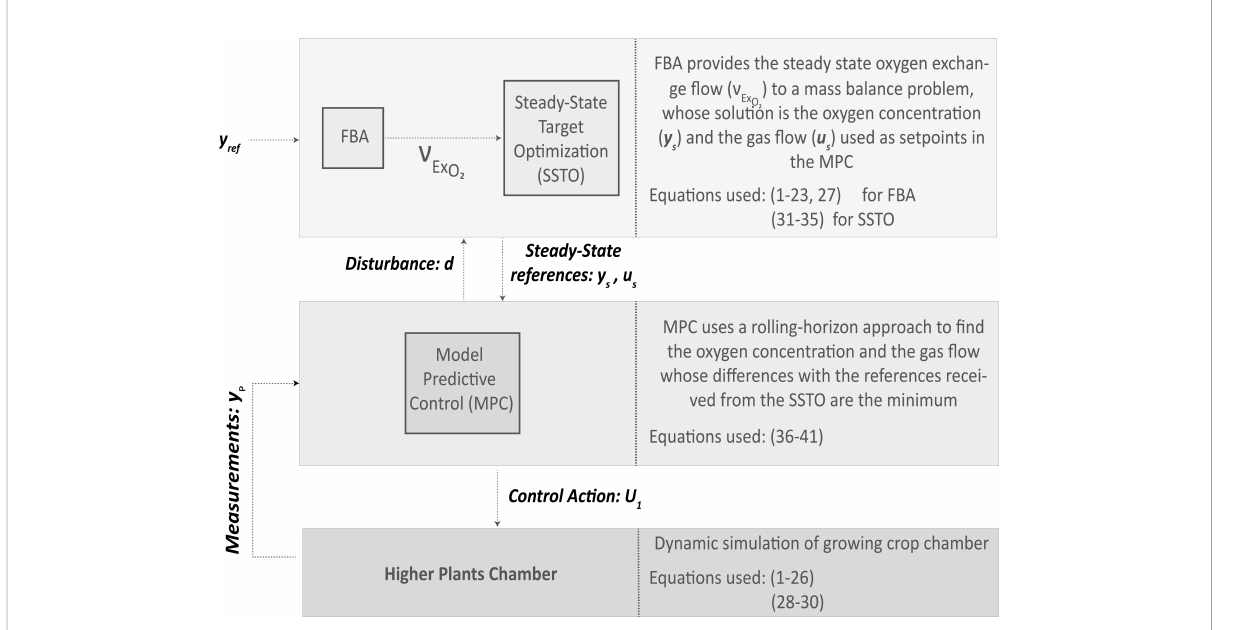
FIGURE 3 Scheme of the advanced control architecture proposed to integrate metabolic